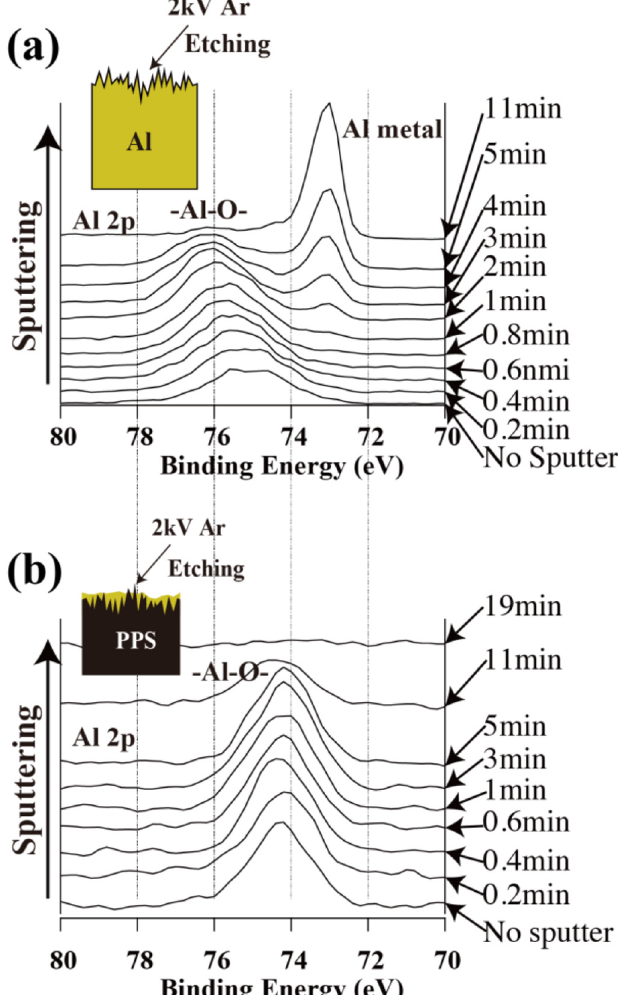
Fig. 7. XPS depth pro fi les of Al 2 p signals of (a) the Al surface before the bonding and of (b) the Al/PPS interface after the removal of Al by HCl